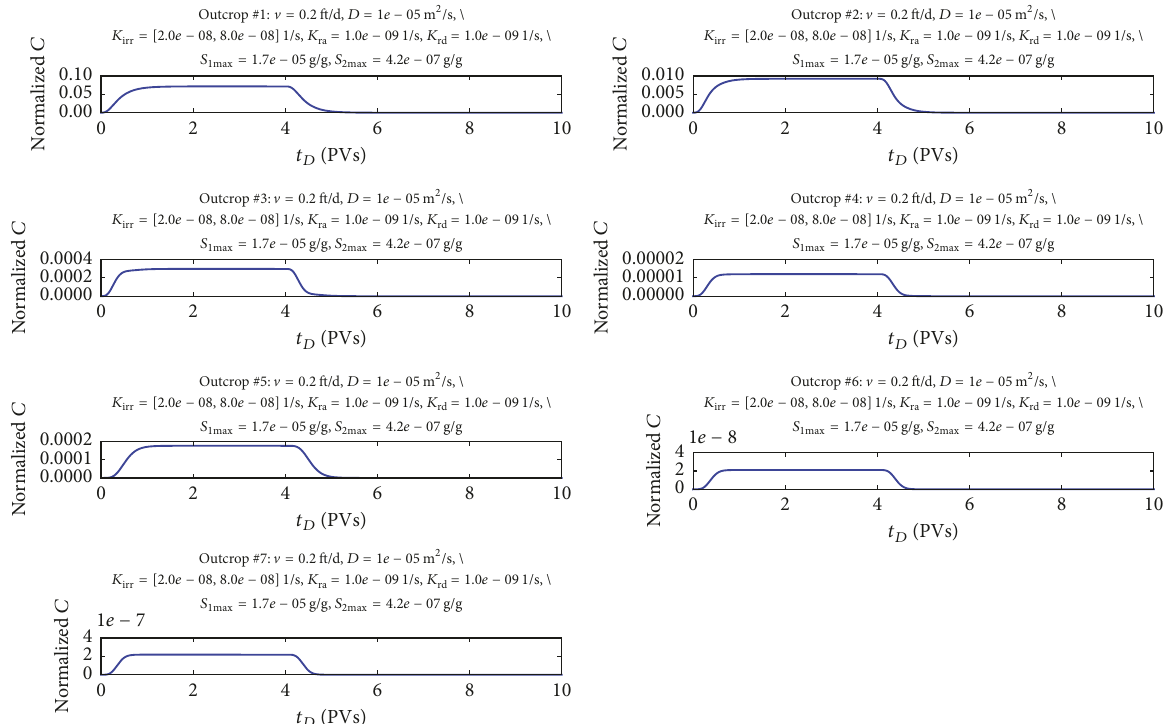
Figure 11: Effluent NP concentration for seven outcrops at field